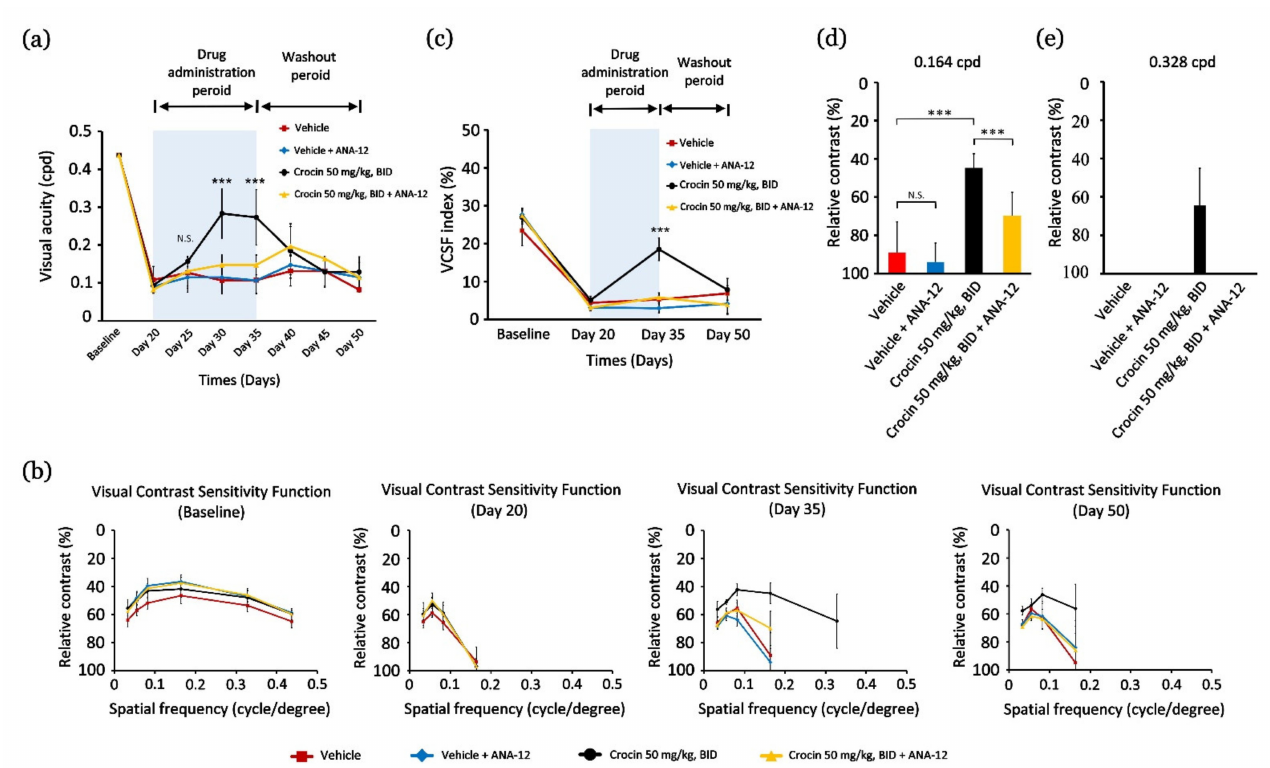
Figure 2. Crocin elevates and restores the thresholds of residual functional vision via activating the BDNF–TrkB pathway. ( a ) The change in the VA threshold following crocin treatment and